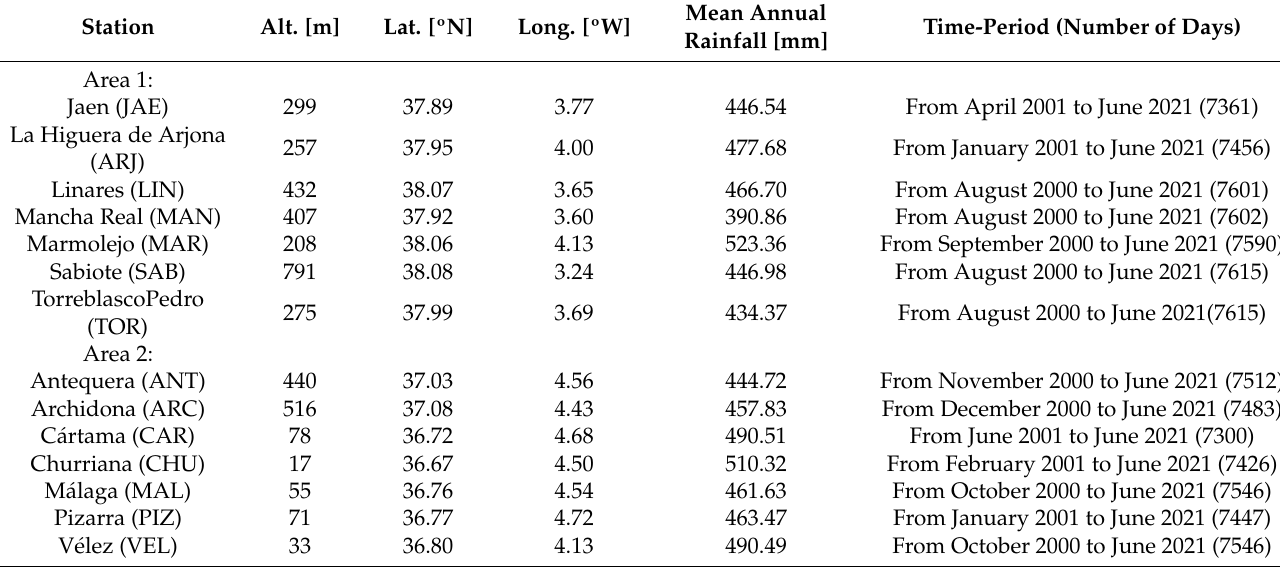
Figure 1. Spatial distribution of the fourteen automated weather stations used in this work. Table 1. Geo-climatic characteristics of the AWS assessed in this work (lat.: latitude; long.: longitude; alt.: elevation above mean sea level).